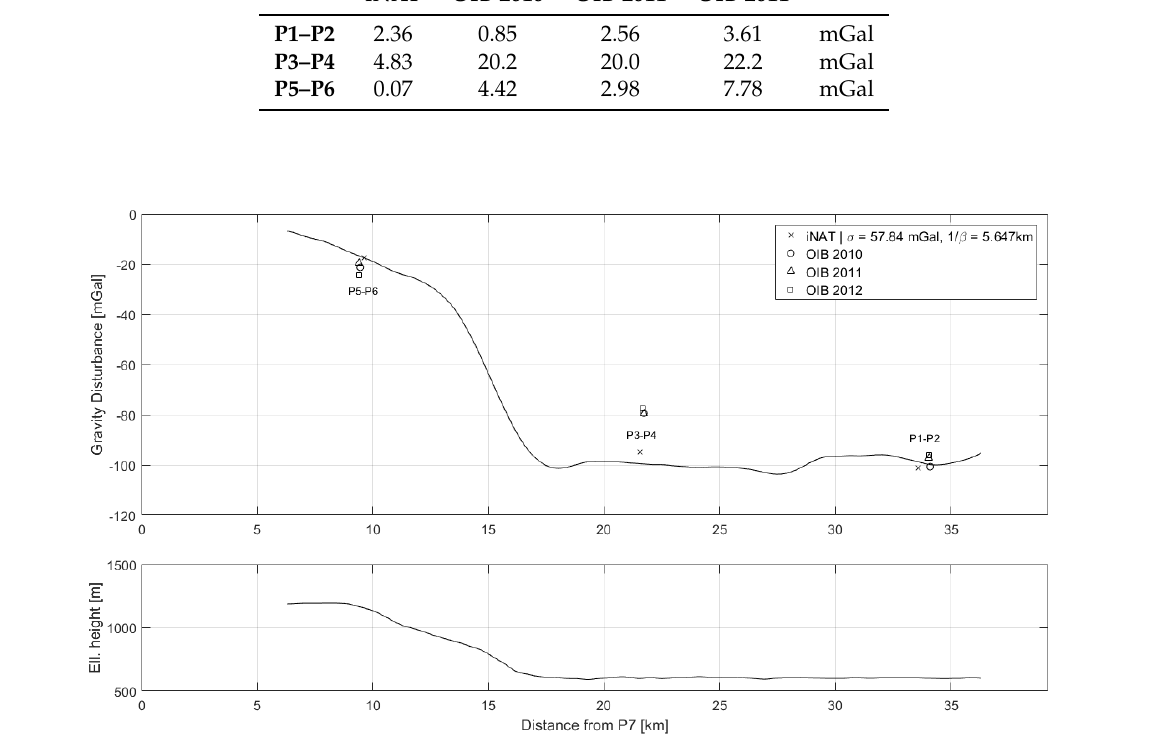
Figure 9. Profile along the P7-KAGA line which crosses over the three OIB lines: ( top ) gravity disturbance profile along with values from crossing lines; ( bottom ) height